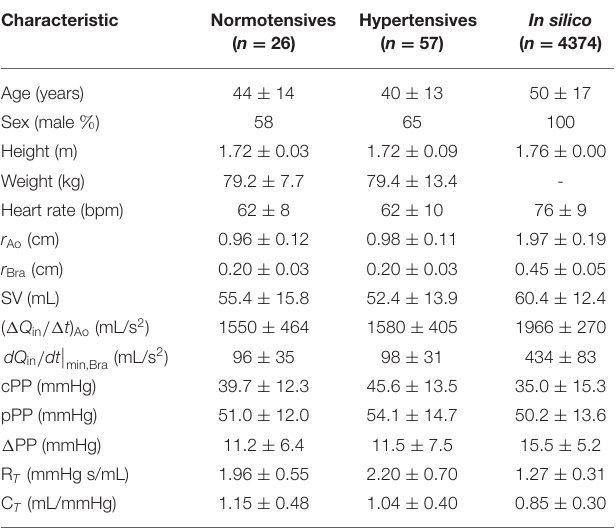
TABLE 1 | Characteristics of the datasets: normotensive (second column) and hypertensive (third column) in vivo subjects and in silico subjects (fourth column). In silico Characteristic Normotensives Hypertensives ( n = 26) ( n = 57) ( n = 4374)